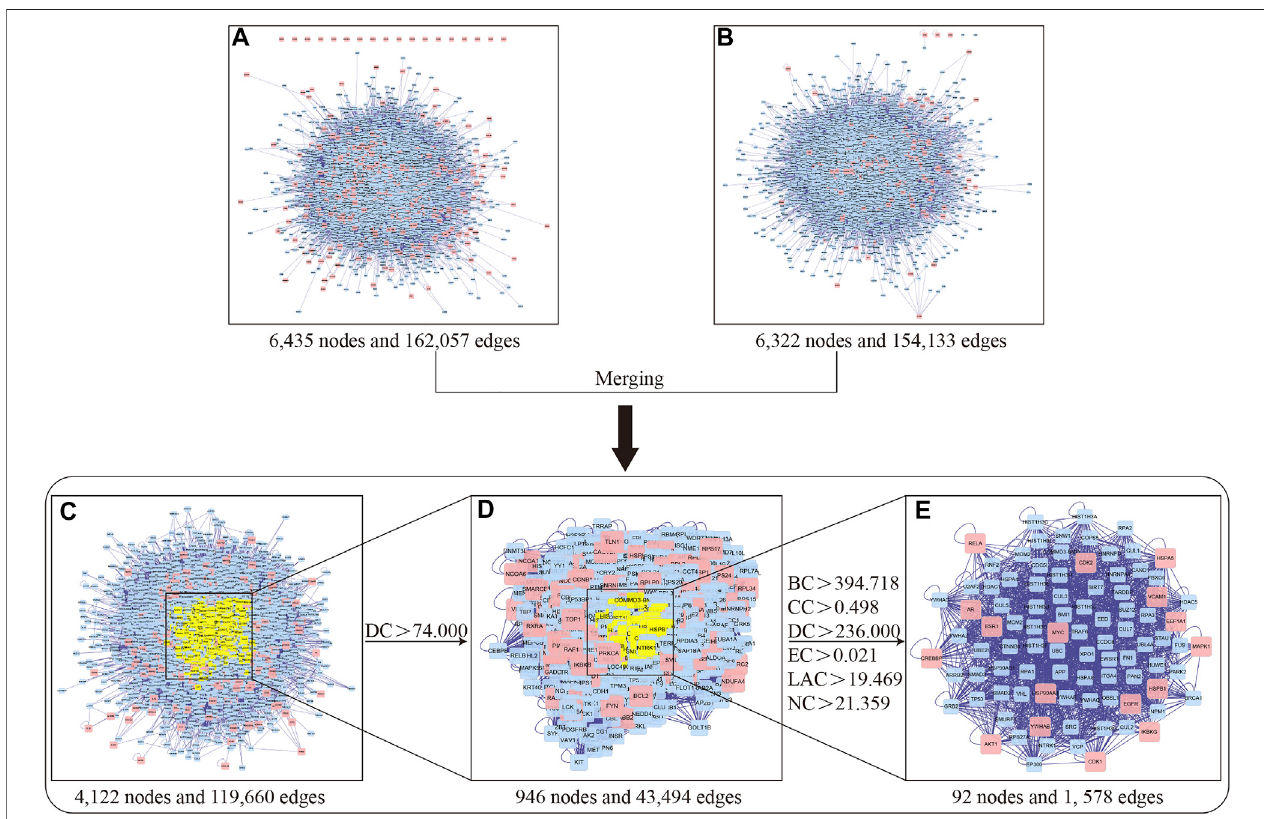
FIGURE4| Identi fi cation ofcorenetworkand targets ofYZQX againstAD withdepression. (A) AD withdepression-related targets PPInetwork. (B) YZQXputative targets PPI network. (C) The interactive PPI network of YZQX putative targets and AD with depression-related targets. (D) PPI network of signi fi cant targets extracted from Panel (C) . (E) PPI network of candidate YZQX targets for AD with depression treatment extracted from Panel (D) . Notes: AD, Alzheimer ’ s disease; DC, degree centrality;BC,betweenness centrality;CC,closenesscentrality;EC,eigenvectorcentrality;LAC,localaverageconnectivity-basedmethod;